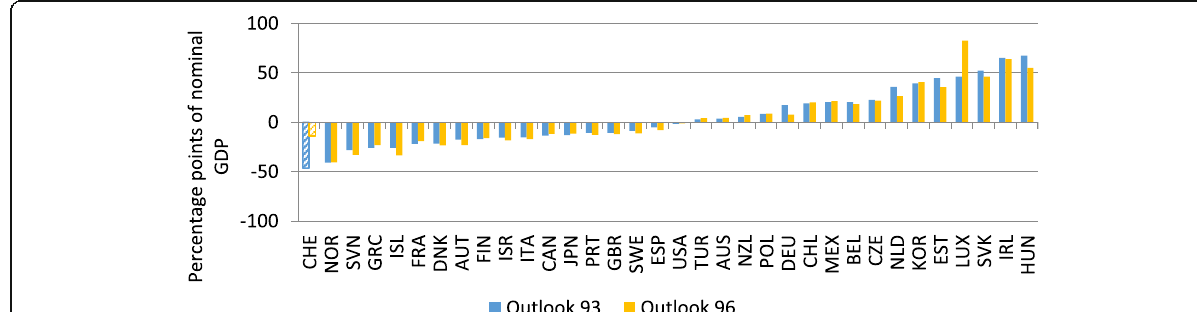
Fig. 9 Comparison of estimated and actual trade openness (Model 4). Year: 2012, Source: Authors ’ calculation based on information by SECO and OECD (2014a)